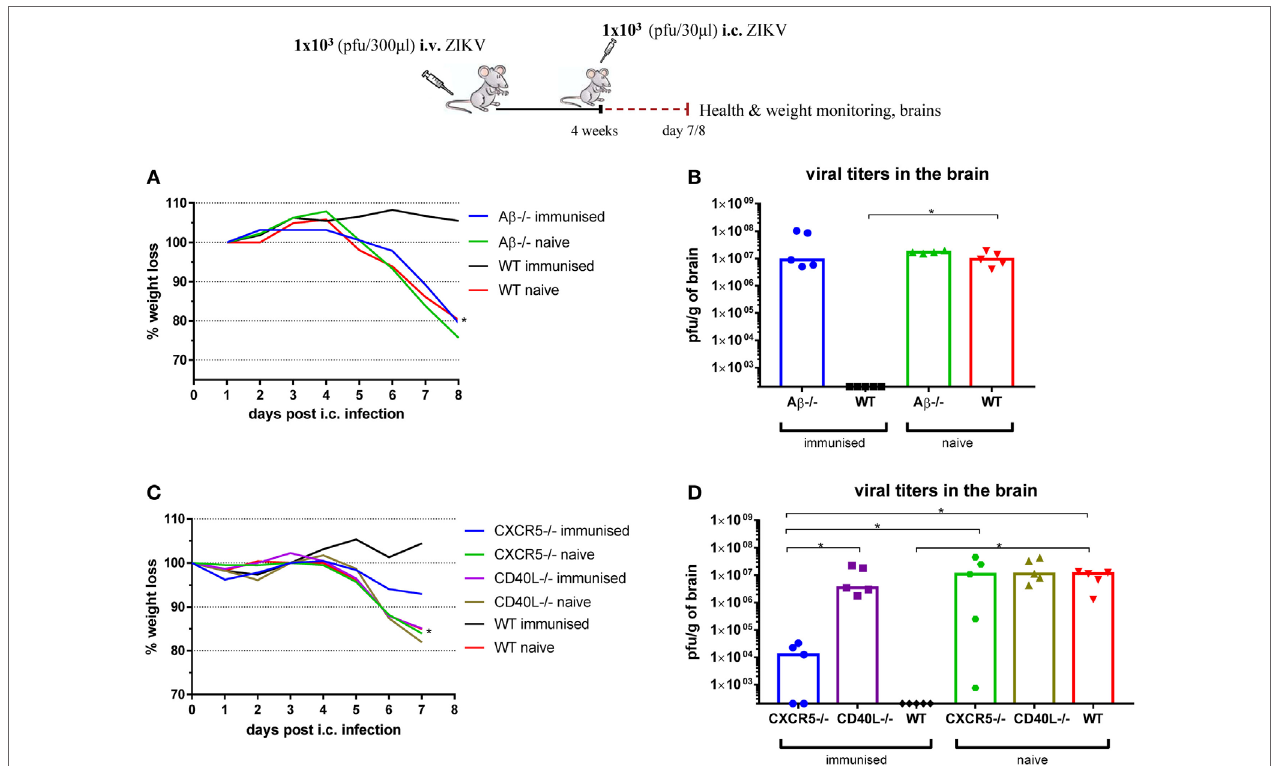
FigUre 13 | CD4 T cells are essential for protection against Zika virus (ZIKV). MHC class II-deficient (A β − / − ) (a,B) or CXCR5-deficient (CXCR5 − / − ) and CD40L- deficient (CD40L − / − ) (c,D) mice were inoculated with 1 × 10 3 pfu ZIKV i.v. and 4 weeks later were challenged with 1 × 10 3 pfu ZIKV i.c. Mice were weighed and monitored daily (a,c) , and on day 7 post i.c. challenge, brains were removed and viral titers were measured by a plaque assay (B,D) . For all deficient mice, a group of uninfected deficient mice was included for control. Additionally, wild-type (WT) C57BL/6 mice, inoculated with 1 × 10 3 pfu ZIKV i.v., and naive uninfected mice were used as positive and negative controls, respectively. The detection limit for virus in the brain was 250 pfu/g organ. Each dot represents an individual animal. The results illustrate the group medians. The weight curves depict the group medians. n = 4–5 mice/group, * p < 0.05. For the weight curves, immunized and naïve mice of the same strain have been compared, and the color of the star marks the immunized group used in the statistical